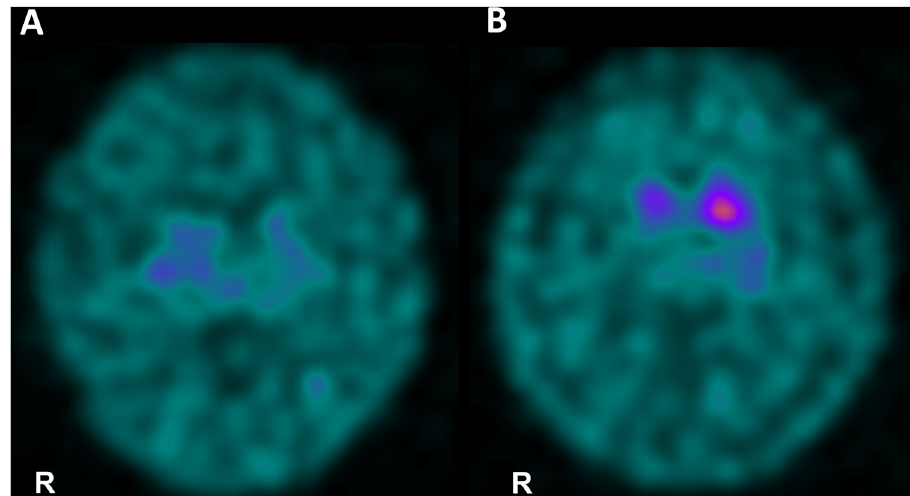
Fig. 2 DAT images for case 1 ( a ) and case 2 ( b ) are presented. Both images reveal decreased DAT uptake in the striatum. Speci fi c binding ratios were semiquantitatively calculated using DaT View software (Nihon Medi-Physics, Tokyo, Japan) based on Bolt ’ s method. 10 The right and left speci fi c binding ratios were 1.87 and 1.71, respectively, in ( a ) and 2.50 and 4.19, respectively, in ( b ). The reported cut-off value was 4.5.